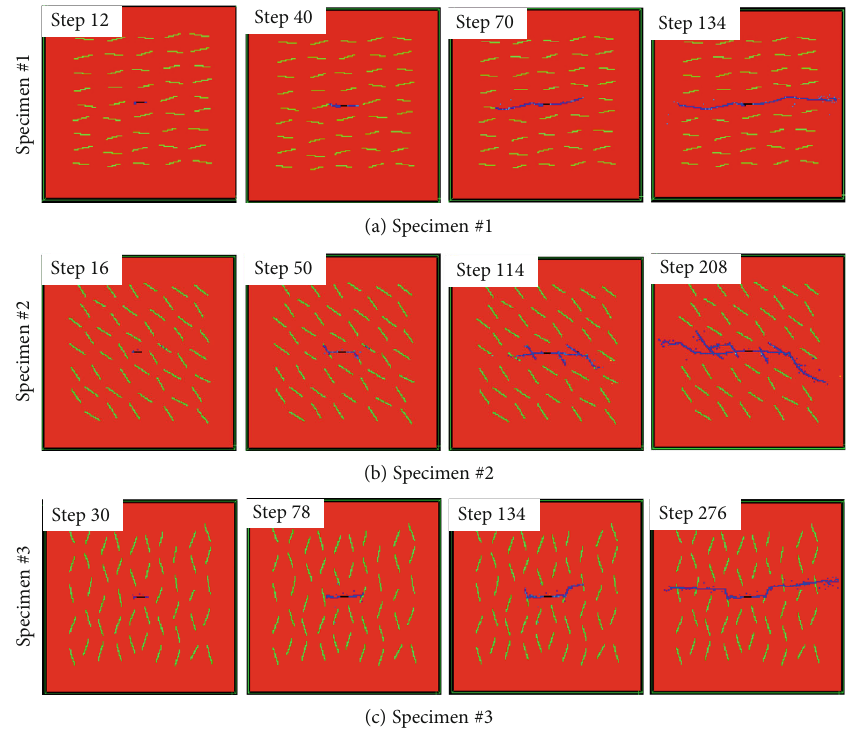
Figure 6: Propagation patterns of HFs in di ff erent stages of each numerical model.